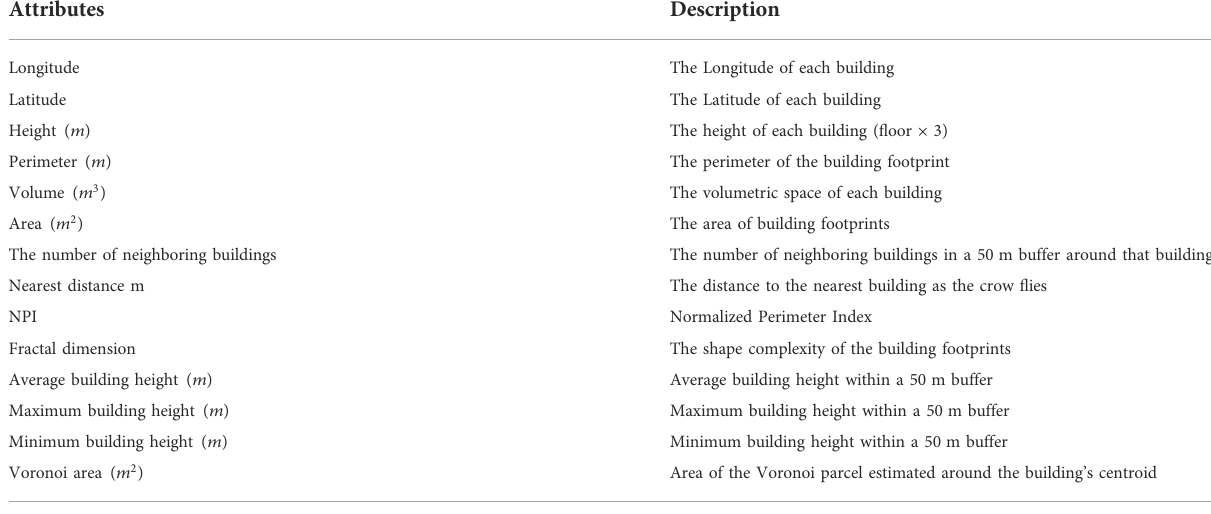
TABLE 1 Potential variables to estimate building vintage based on the RF model.